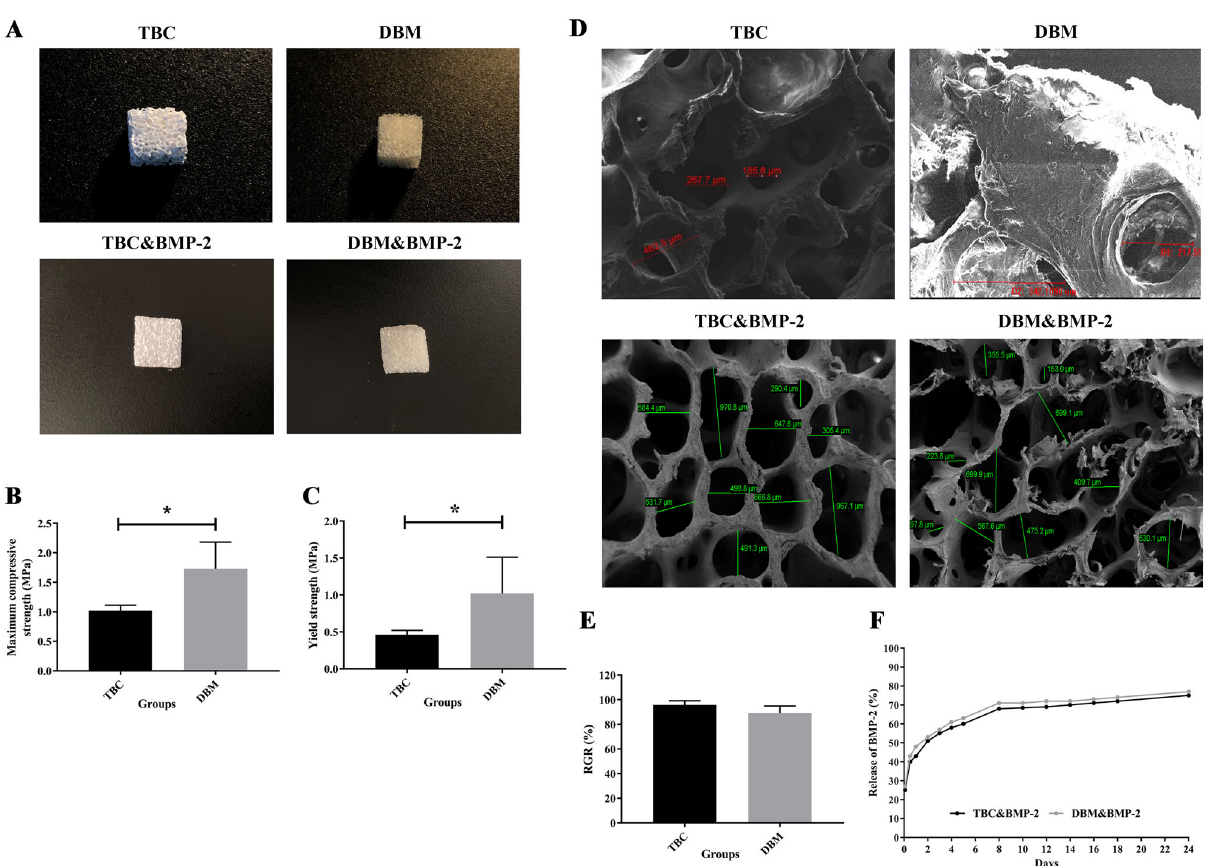
Fig. 1 Characterization of TBC, DBM, TBC&BMP-2 and DBM&BMP-2. A The photographs of TBC, DBM, TBC&BMP-2 and DBM&BMP-2; B The maximum compressive, n = 5; C The